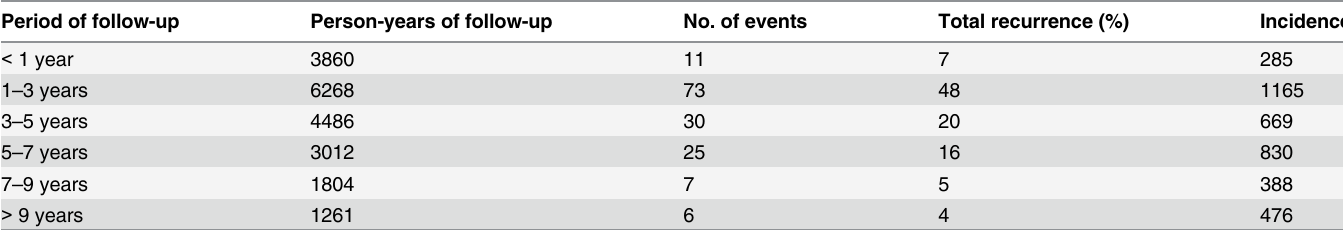
Table 3. Time to tuberculosis recurrence by year since